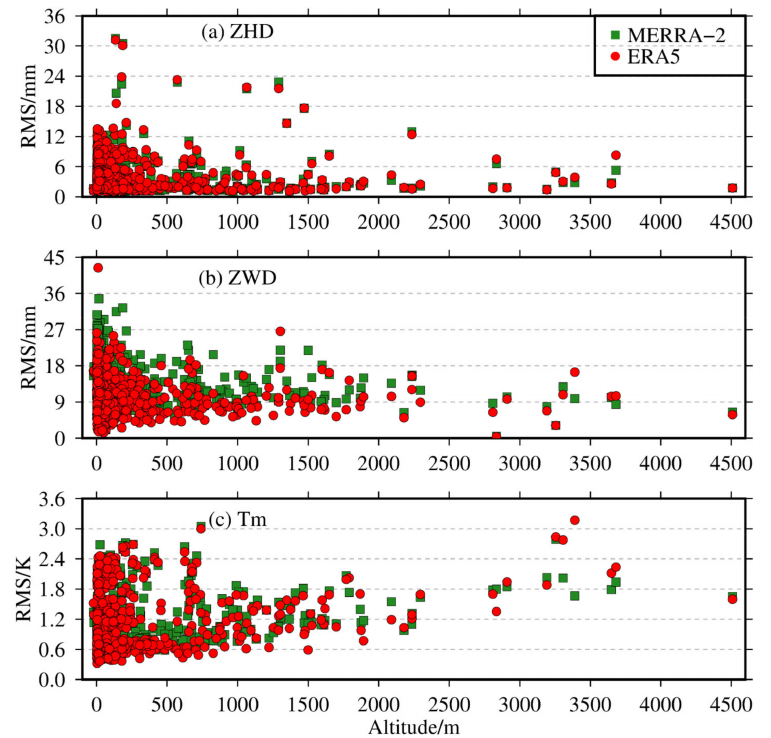
Figure 15. Variations with altitudes of the annual mean ( a – c ) RMS values of ZHD, ZWD, and T m over the globe from 2016 to